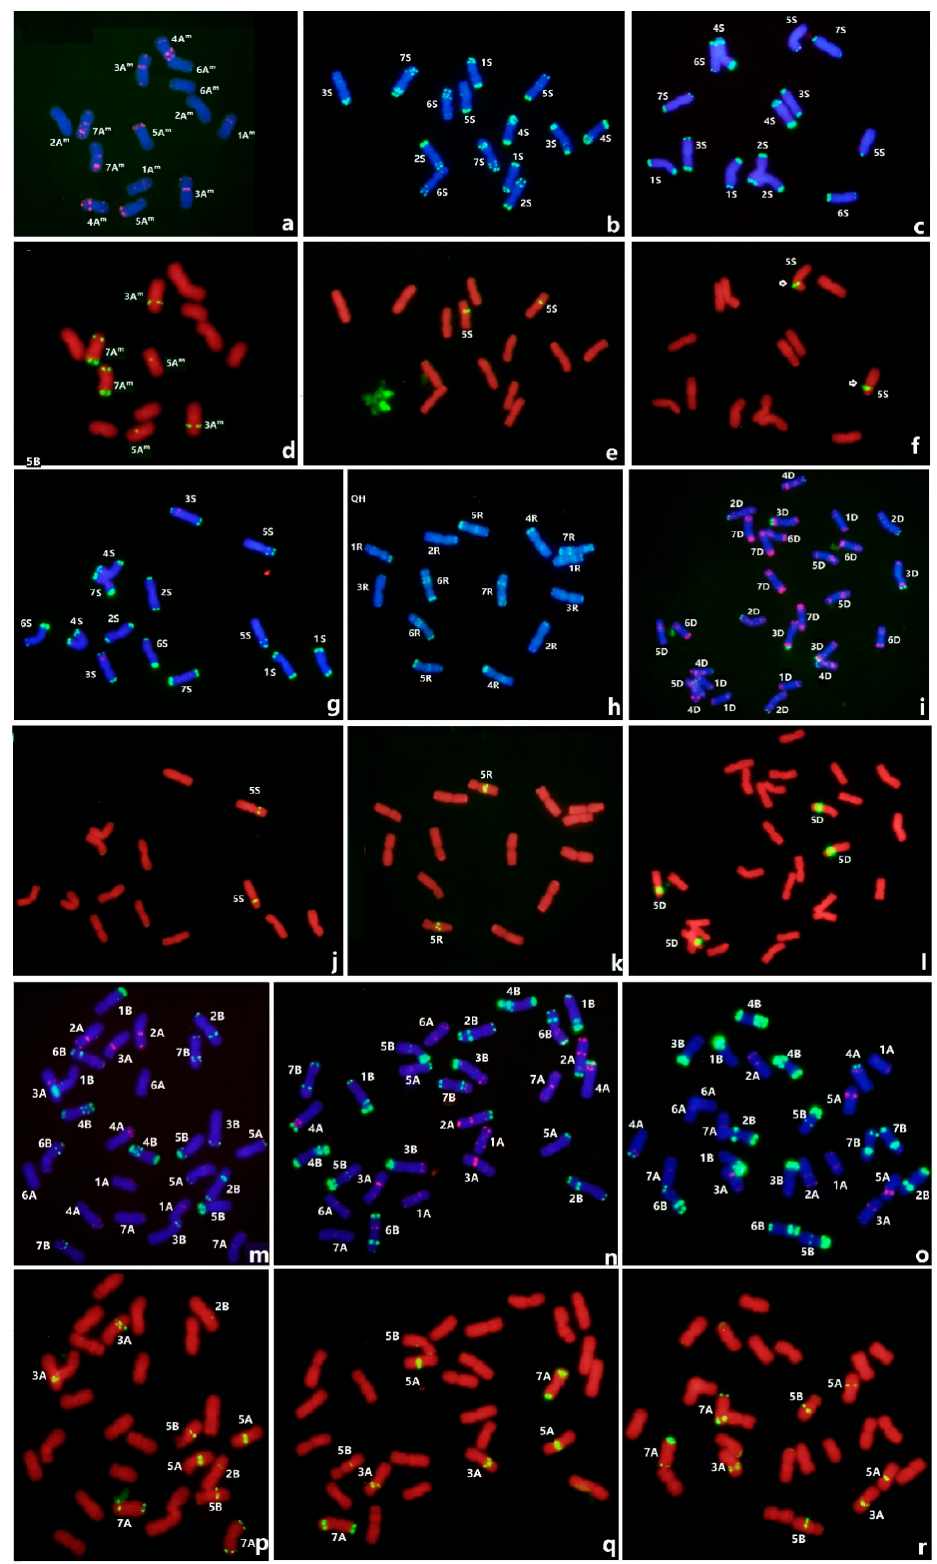
Figure 5. Hybridization of the ND-FISH probes on chromosomes of T. monococcum ( a , d ), Ae. speltoides ( b , e ), Ae. longissima ( c , f ), Ae. searsii ( g , j ), Secale cereale ( h , k ), tetraploid Ae. tauschii ( i , l ), T. durum ( m , p ), T. carthlicum ( n , q ), and T. dicoccoides ( o , r ). The probes Oligo-pSc119.2 (green) and pTa535 (red) ( a – c , g – i , o – p ), and sequential Oligo-3A1 (green) ( d – f , j – l , p – r ) were used, respectively. Table 3. The differential hybridization patterns of Ta-3A1 among tetraploid wheat.